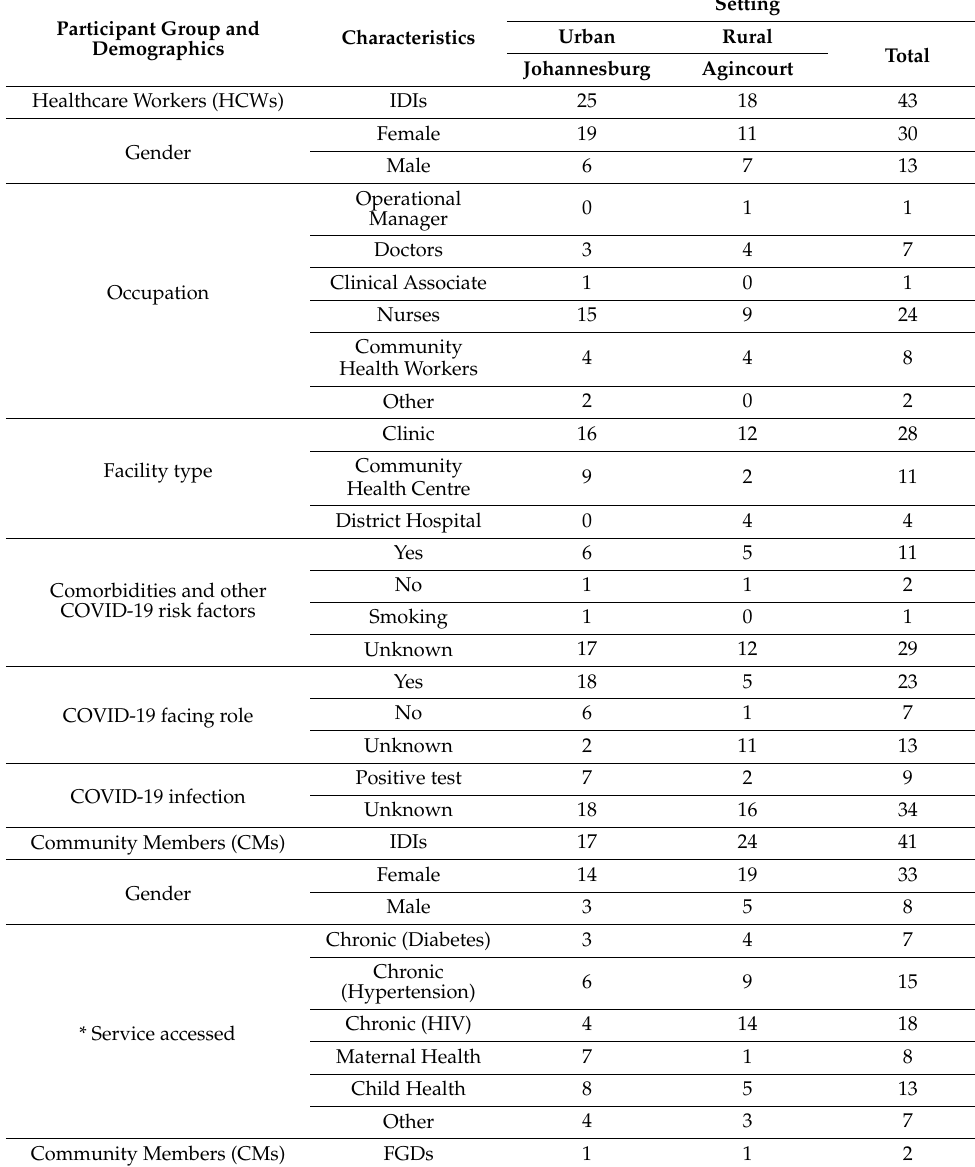
Table 2. Number of interviews conducted and participants’ demographics and